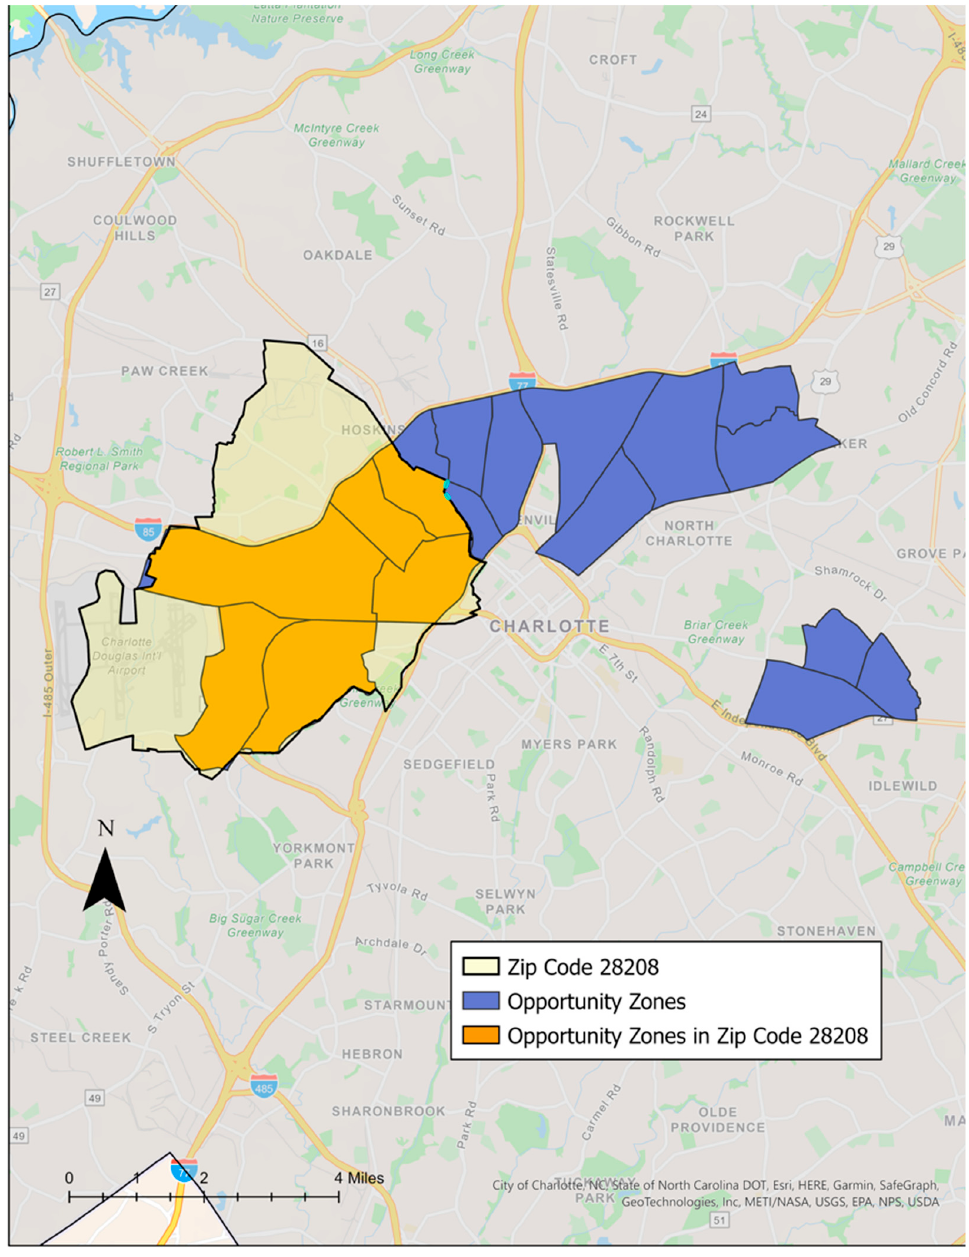
Figure 2. Map of Opportunity Zones in Charlotte, NC with Emphasis on ZIP Code 28208.